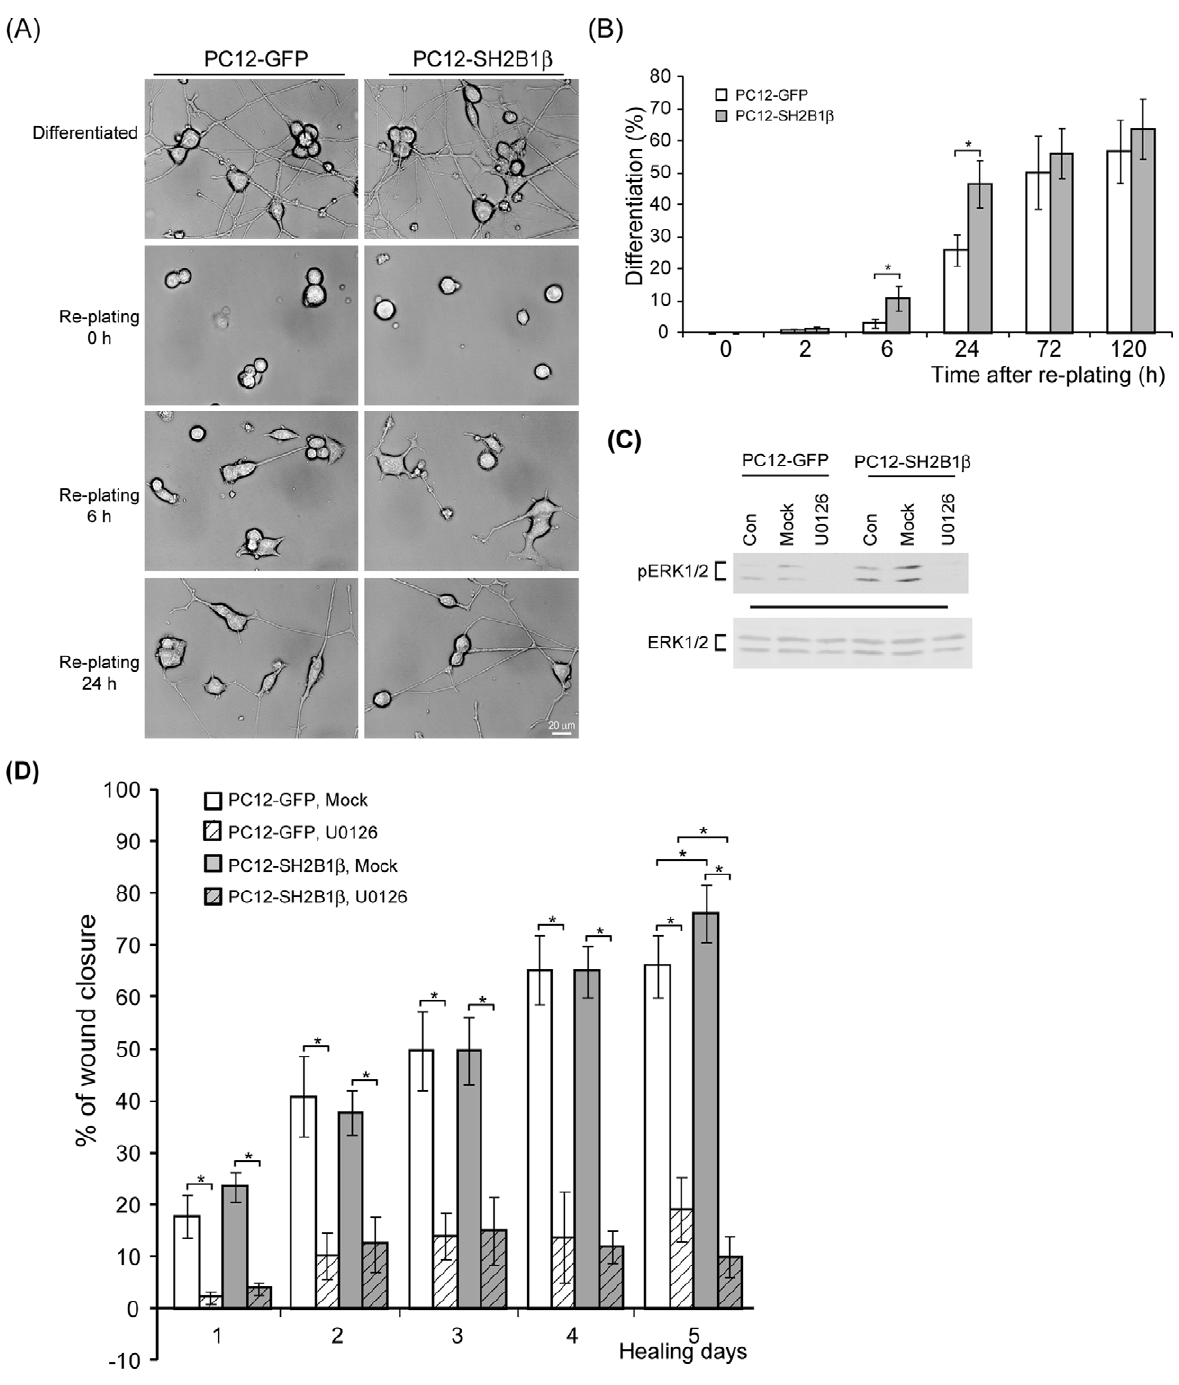
Figure 2. Overexpression of SH2B1 b promotes pERK1/2-dependent neurite re-growth of differentiated PC12 cells after injury. (A) PC12-GFP and PC12-SH2B1 b cells were differentiated as in Figure 1. On day 8, differentiated cells were trypsinized and neurites were removed via pippeting up and down. Live cell images of re-plated cells were taken over time. Representative images are shown. Scale bar: 20 m m. (B) Percentages of differentiated cells were determined as described in the Materials and Methods. Values are mean 6 S.E.M. from four independent experiments. (*: P , 0.05, paired Student’s t-test) (C) PC12-GFP and PC12-SH2B1 b cells were differentiated as in Figure 1. On day 8, cells were pre-treated with DMSO (Mock) or 20 m M U0126 for 1 h before wounding. Cell lysates were extracted on healing day 12 and resolved via SDS-PAGE followed by immunoblotting using antibodies against pERK1/2 and ERK1/2. (D) Percentages of wound closure were determined as in Figure 1. Values are mean 6 S.E.M from at least three independent experiments. (*: P , 0.05, paired Student’s t-test). doi:10.1371/journal.pone.0034999.g002 containing 1 mM Na 3 VO 4 , 1 mM PMSF, 10 ng/ml aprotinin precipitated proteins were subjected to SDS-PAGE and Western and 10 ng/ml leupeptin. Cell lysates were incubated with blotting. The immunoblots were detected using either IRDye- monoclonal PKC antibodies (1:200) overnight at 4 u C. Immuno- conjugated IgG and the Odyssey Infrared Imaging System (LI-